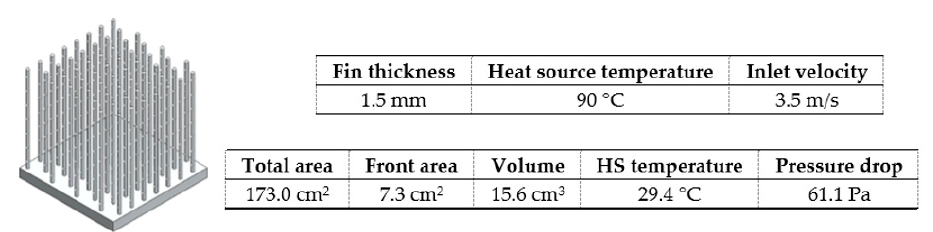
Figure 16. Best pin heat sink (among those studied).